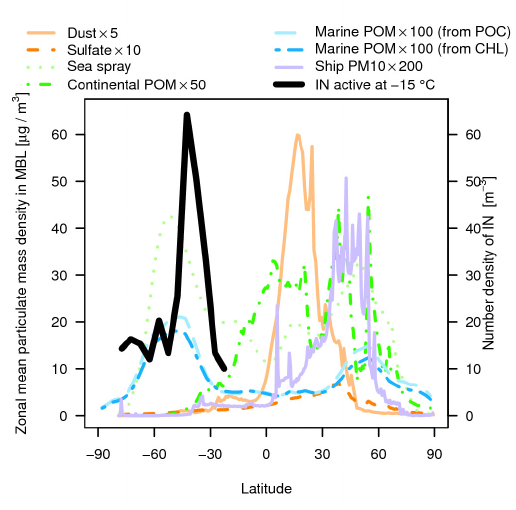
Fig. 4. Latitudinal dependence of aerosol surface concentrations over oceans. Left axis: mean surface mass densities, latitudinal aver- age over oceans. Shown here are dust, sulfate, sea spray, and (conti- nental) POM from the AEROCOM median model (year 2000) (Tex- tor et al., 2006; Kinne et al., 2006; Schulz et al., 2006), simulated marine POM (this work) and estimated particulate matter from ship emissions (year 1970, PM 10 , assuming 5-day residence time in 800- m boundary layer) (Lamarque et al., 2010). Right axis: Observed number densities of IN active at T = − 15 ◦ C, as reported by B73, latitudinal average over sampled